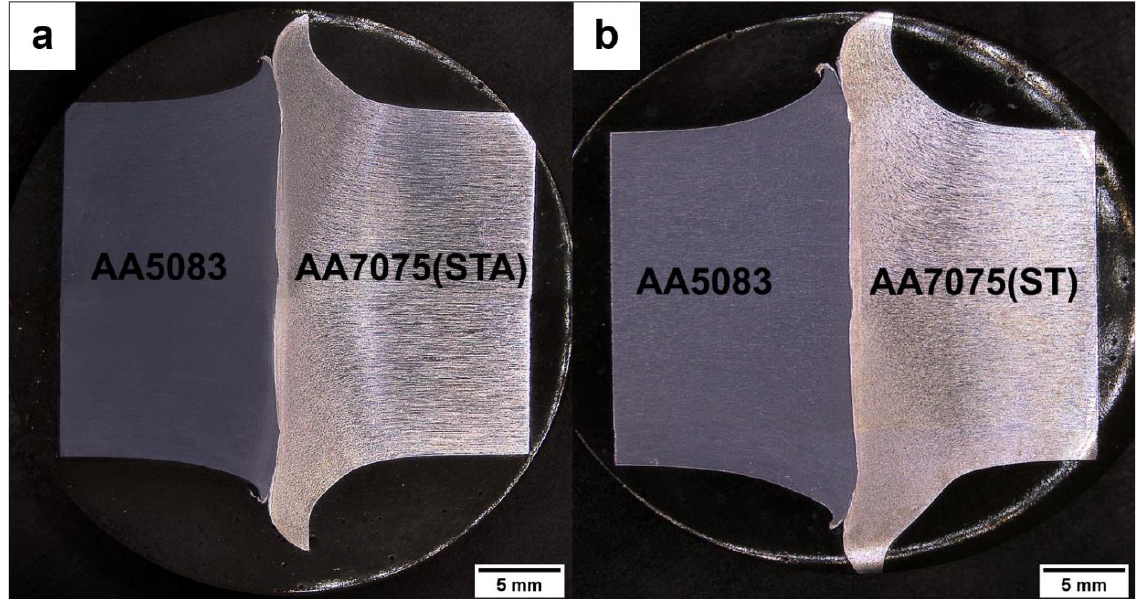
Figure 6. Macrographs of the weldment ( a ) AA5083/AA7075-STA and ( b )